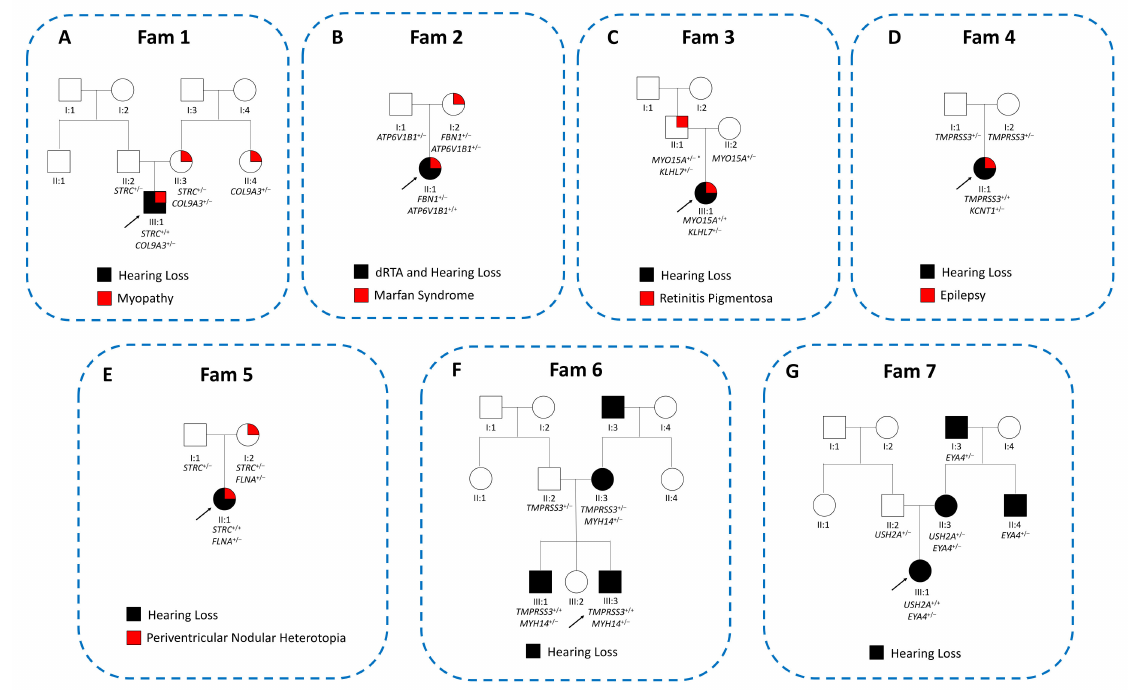
Figure 2. Pedigrees, clinical and genetic data of the families carrying a dual molecular diagnosis. The figure illustrates all the pedigrees of the HL families with a dual molecular diagnosis, with the indication of the main clinical features and the genes involved in the phenotype (i.e., Families 1–7, which correspond to Figure 1, ( A – G ). dRTA = distal renal tubular acidosis. * Individual carrier of two in cis missense variants in the MYO15A